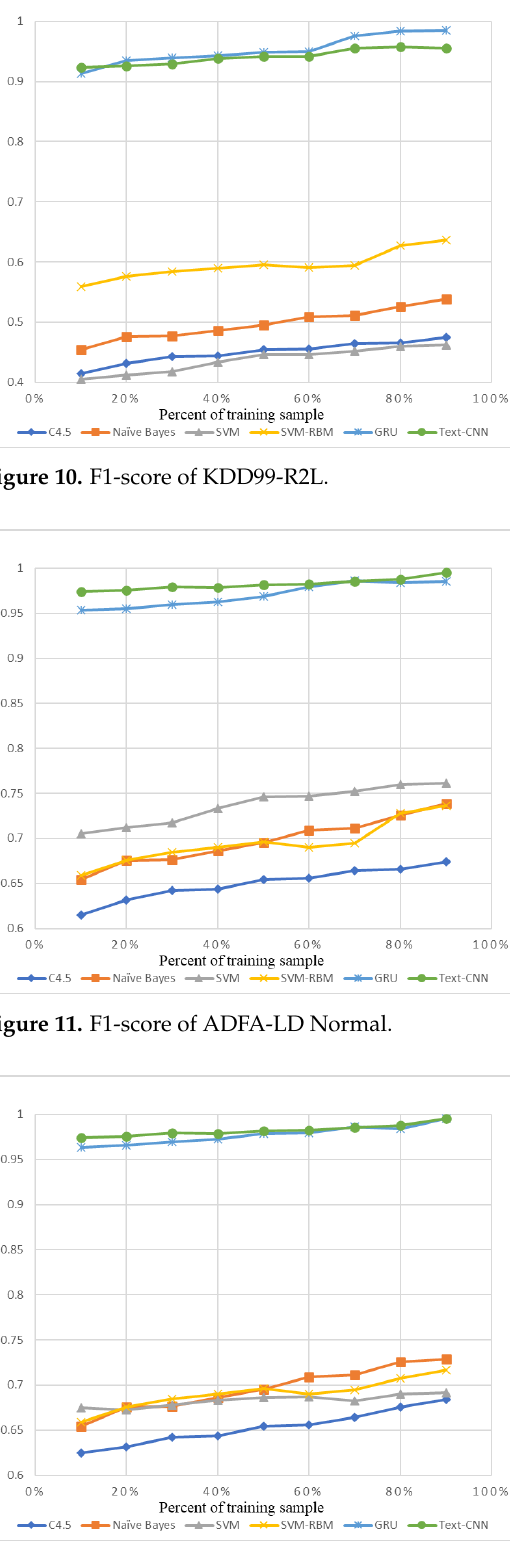
Figure 12. F1-score of ADFA-LD